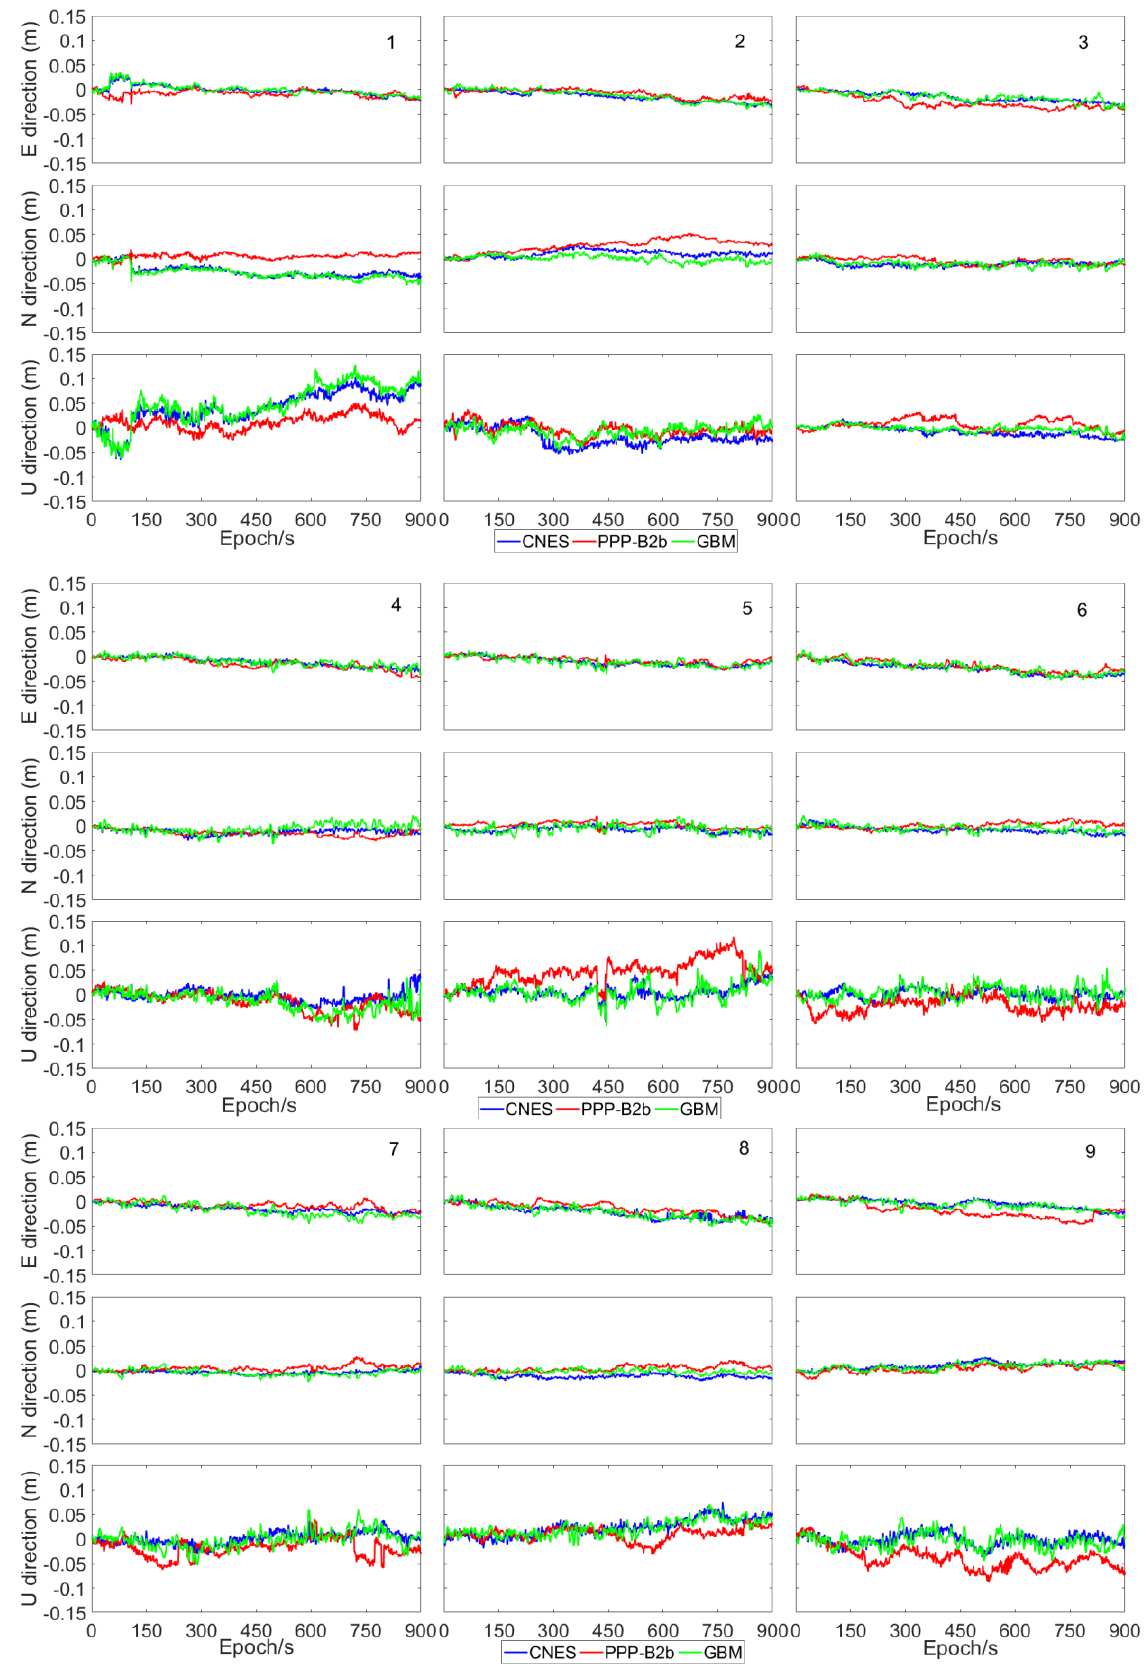
Figure 13. Positioning errors in nine sets of experiments at JFNG station.